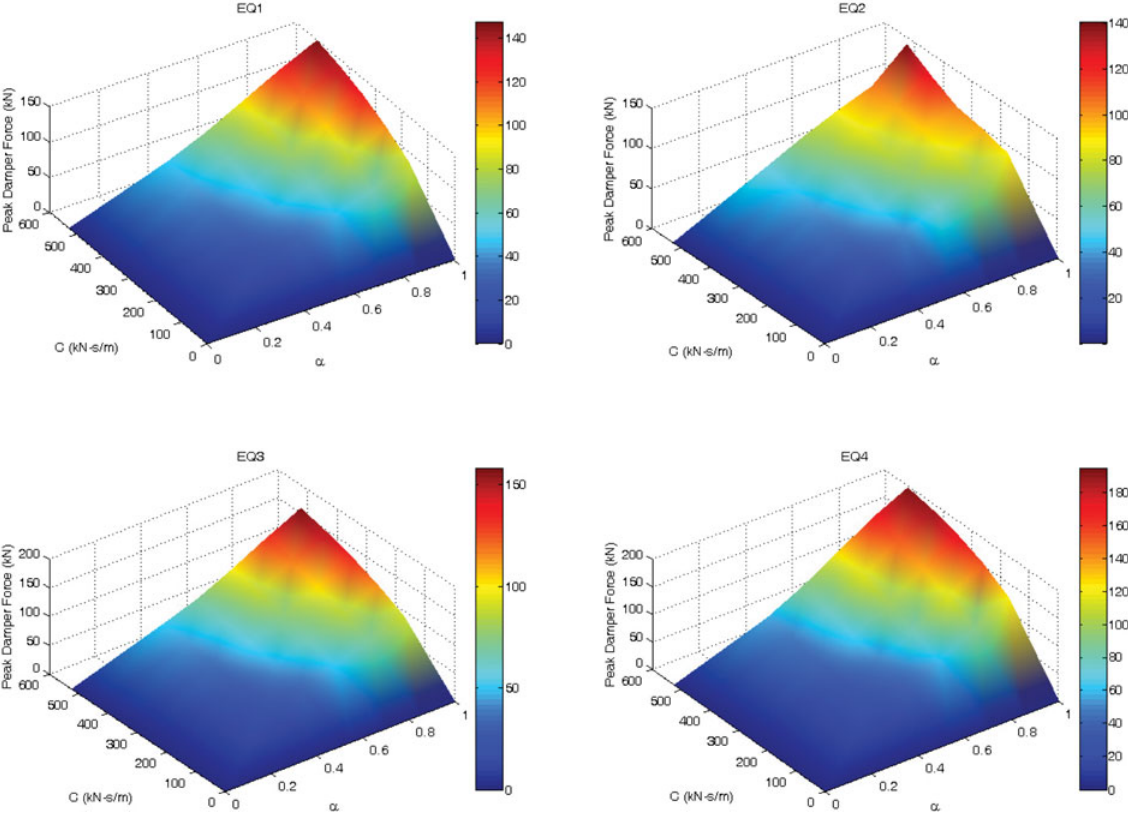
Fig. 5. Peak damper force ( P DF